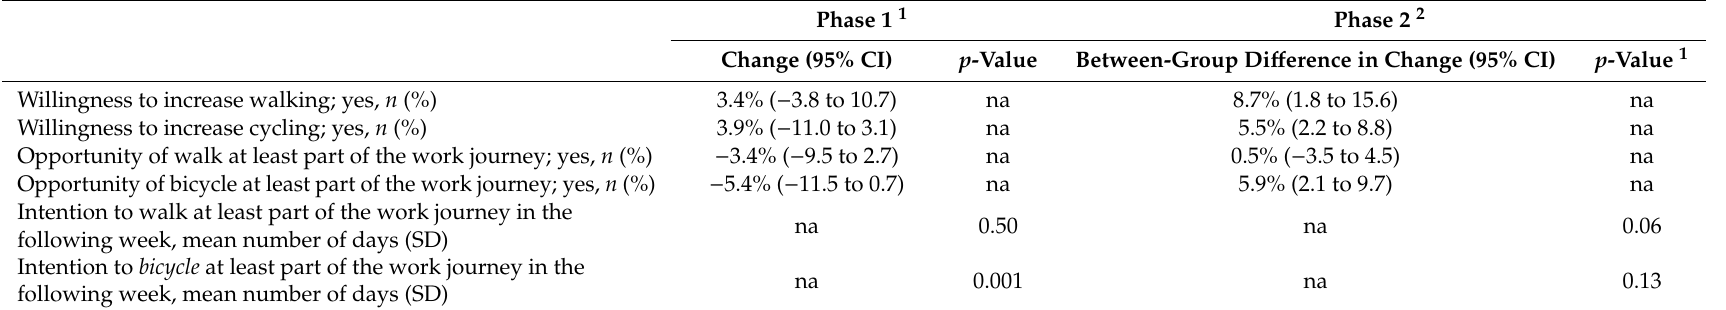
Table 4. Changes in employees’ motivation for ACW before and after Phase 1 and Phase